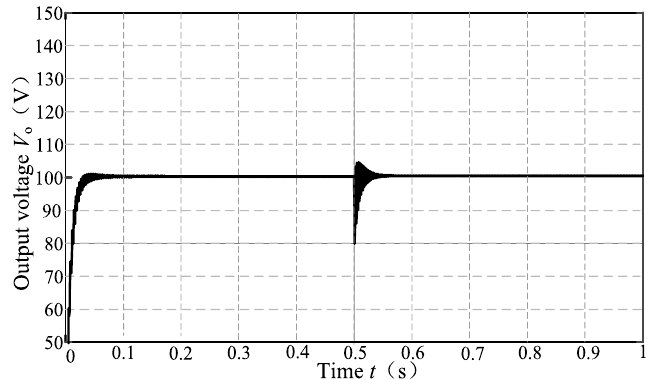
Figure 13. Output voltage stabilized